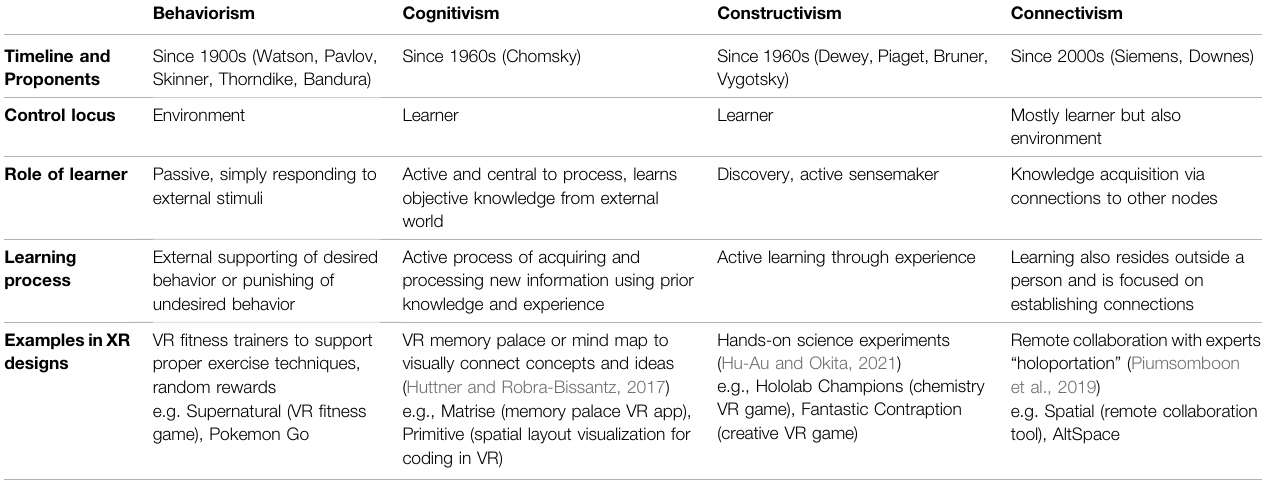
TABLE 2 | Learning paradigms and XR examples (adapted from Ashworth et al., 2004).